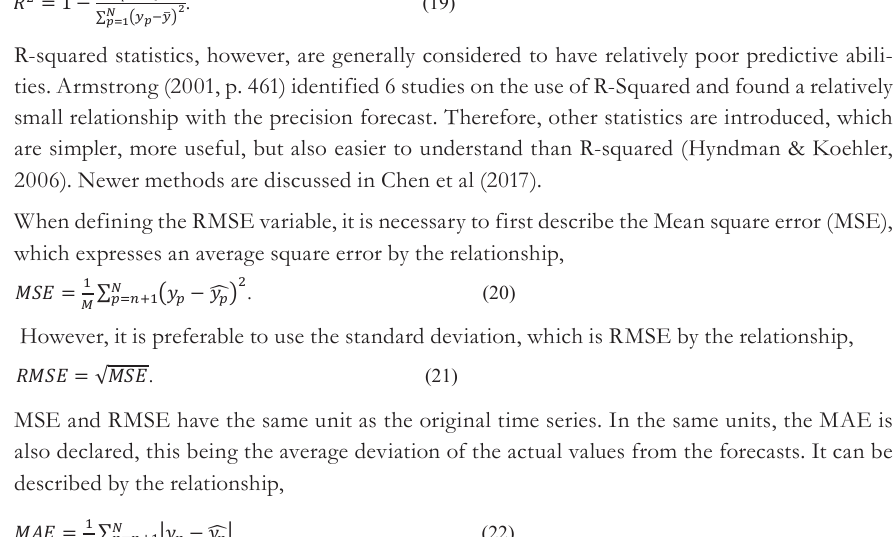
centage. These indicators do not depend on the time series units of measure, and therefore we can use them when comparing the forecast accuracy of different variables. One of these is, for example, MAPE, which represents an average error of forecasts compared to actual values by the relationship,